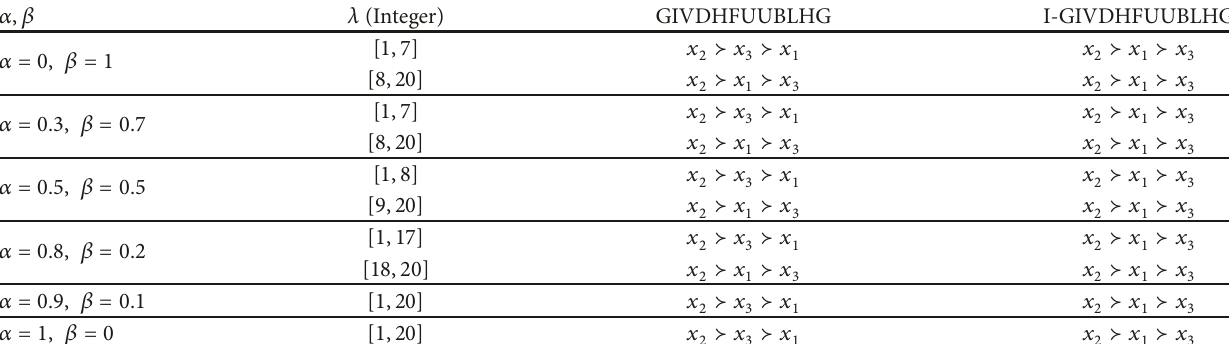
Table 8: Ranking results obtained by GIVDHFUUBLHG and I-GIVDHFUUBLHG along with 𝛼, 𝛽 , and 𝜆 . 𝛼, 𝛽 𝜆 (Integer) GIVDHFUUBLHG I-GIVDHFUUBLHG 𝛼 = 0, 𝛽 =